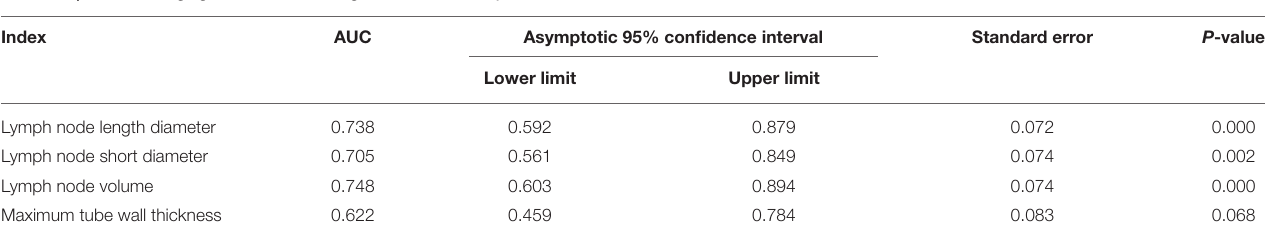
TABLE 1 | Value of imaging results in evaluating short-term